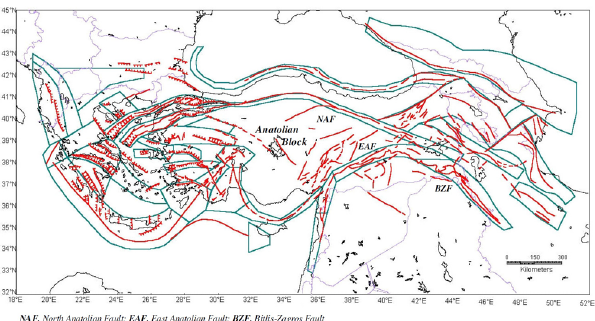
Fig. 7. The seismic source zones of Turkey (USGS, 2012; GSHAP, 2012).